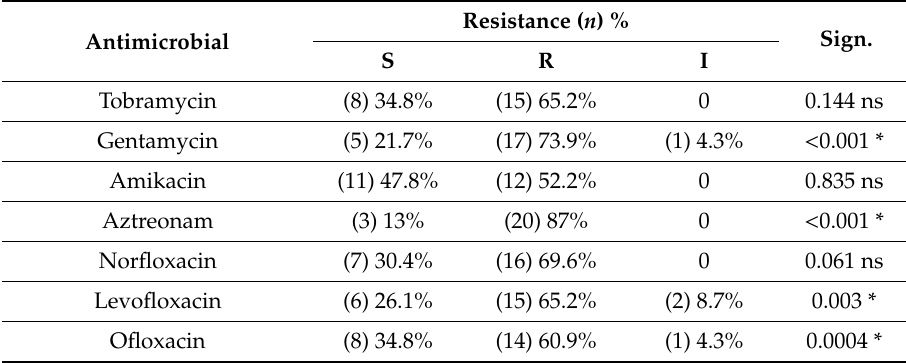
Figure 2. Multiplex PCR identification of OXA carbapenemase gene families in A. baumannii under investigation. A, B, C, and D mark for bla OXA-23 ( 1058 bp), bla OXA-58 (599 bp), bla OXA-51 (353 bp), and bla OXA- 24 (246 bp) fragments, respectively. (M) indicates 100 bp Marker from Genetex, A. baumannii strains in the study from lane 1 to 23, and lane 24 represent bla OXA-23 positive control strain.